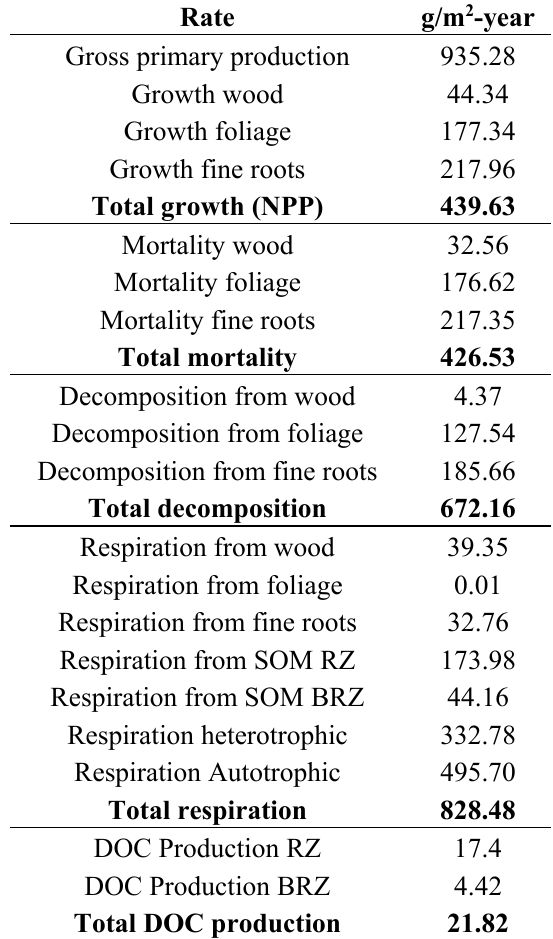
Table 10. Simulated average annual rates defining the carbon model. The rates in bold are summaries across each of the individual compartments.